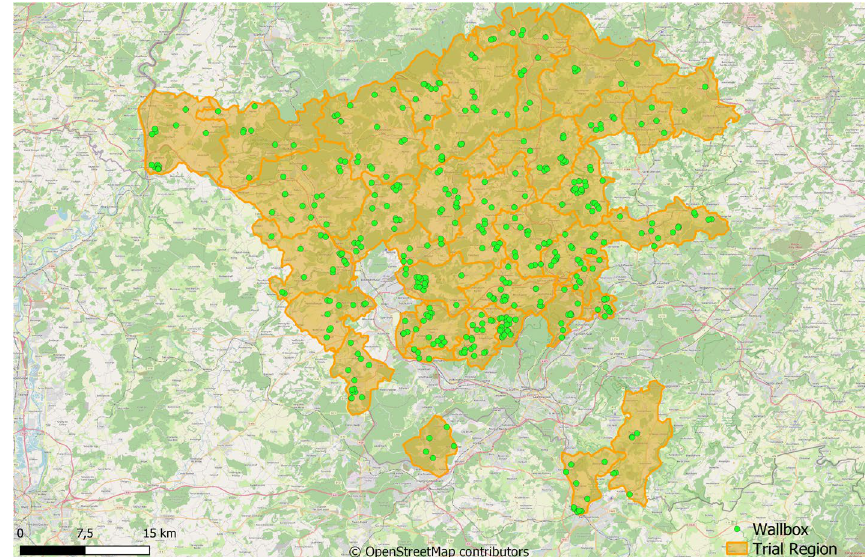
Fig. 1 Trial region and